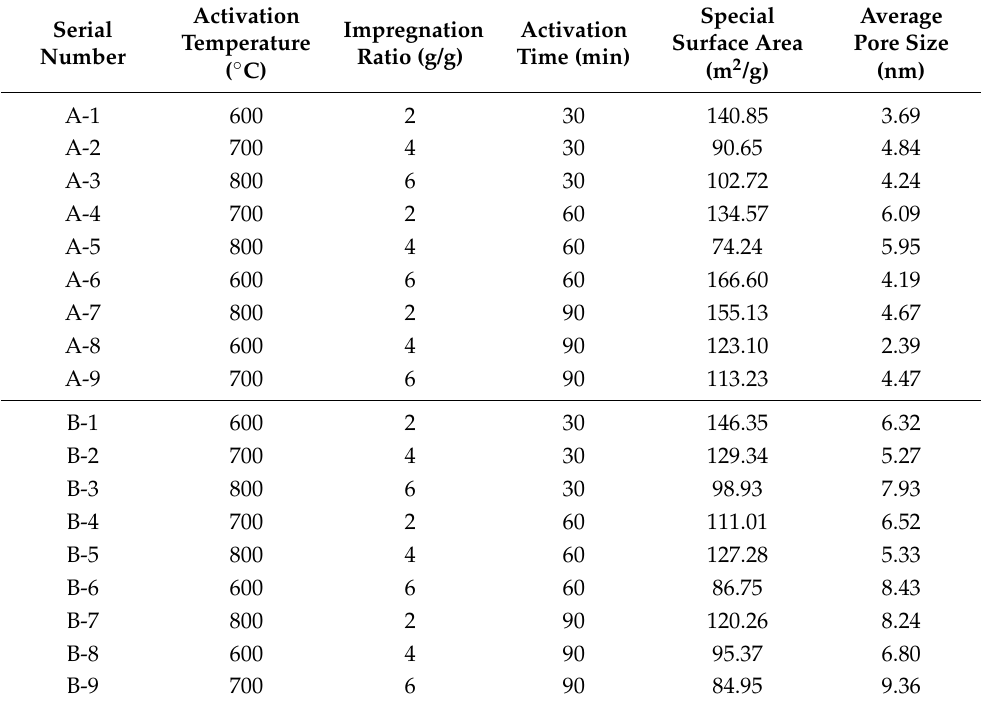
Table 1. Preparation conditions and pore structure properties of ABC.